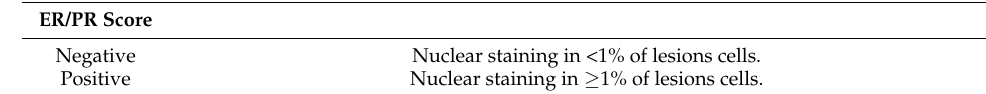
Table 1. IHC classification criteria for HER2, ER and PR evaluation. HER2 Score 0 No staining or membrane staining that is incomplete, weak and in ≤ 10% of lesion cells. 1+ Incomplete membrane staining that is weak in >10% of lesion cells. 2+ Weak to moderate complete membrane staining observed in >10% of lesion cells. 3+